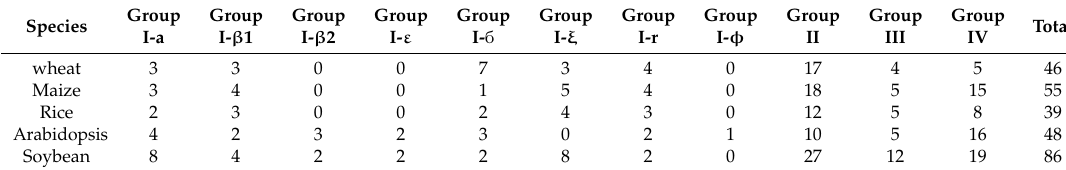
Table 2. The number of HD-Zip genes in wheat, maize, Arabidopsis , rice and soybean.